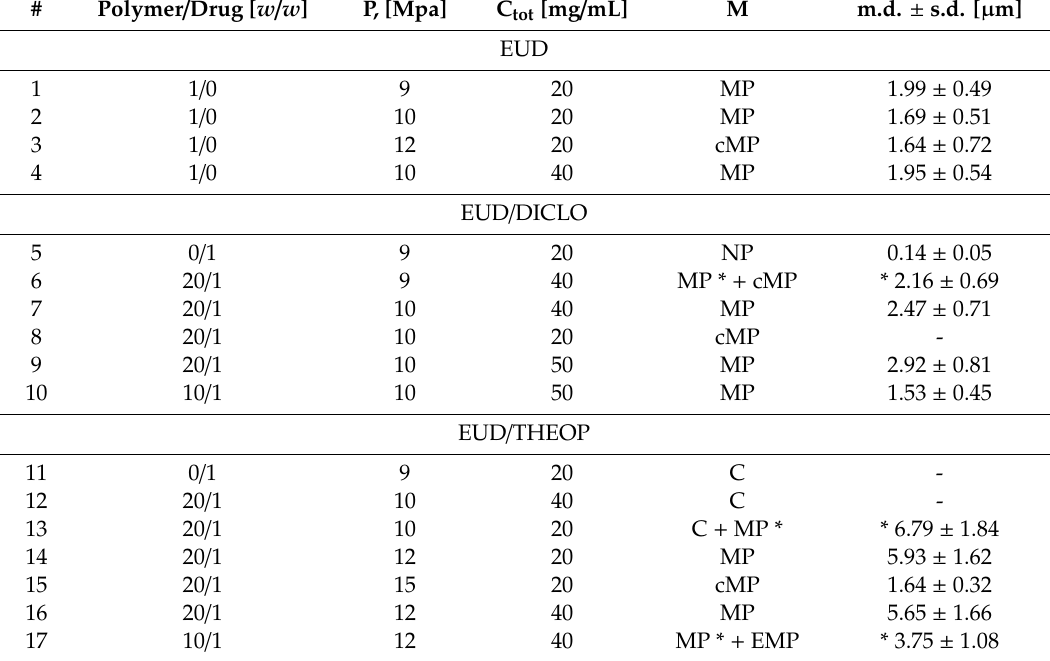
Table 1. A list of SAS tests for Eudragit L100-55 (EUD) micronization, EUD / diclofenac (DICLO) coprecipitation and EUD / theophylline (THEOP) coprecipitation (C, crystals; NP, nanoparticles; MP, microparticles; cMP, coalescing microparticles; EMP, expanded microparticles); when in a single test more than one morphology is obtained, * indicates the one whose diameter is